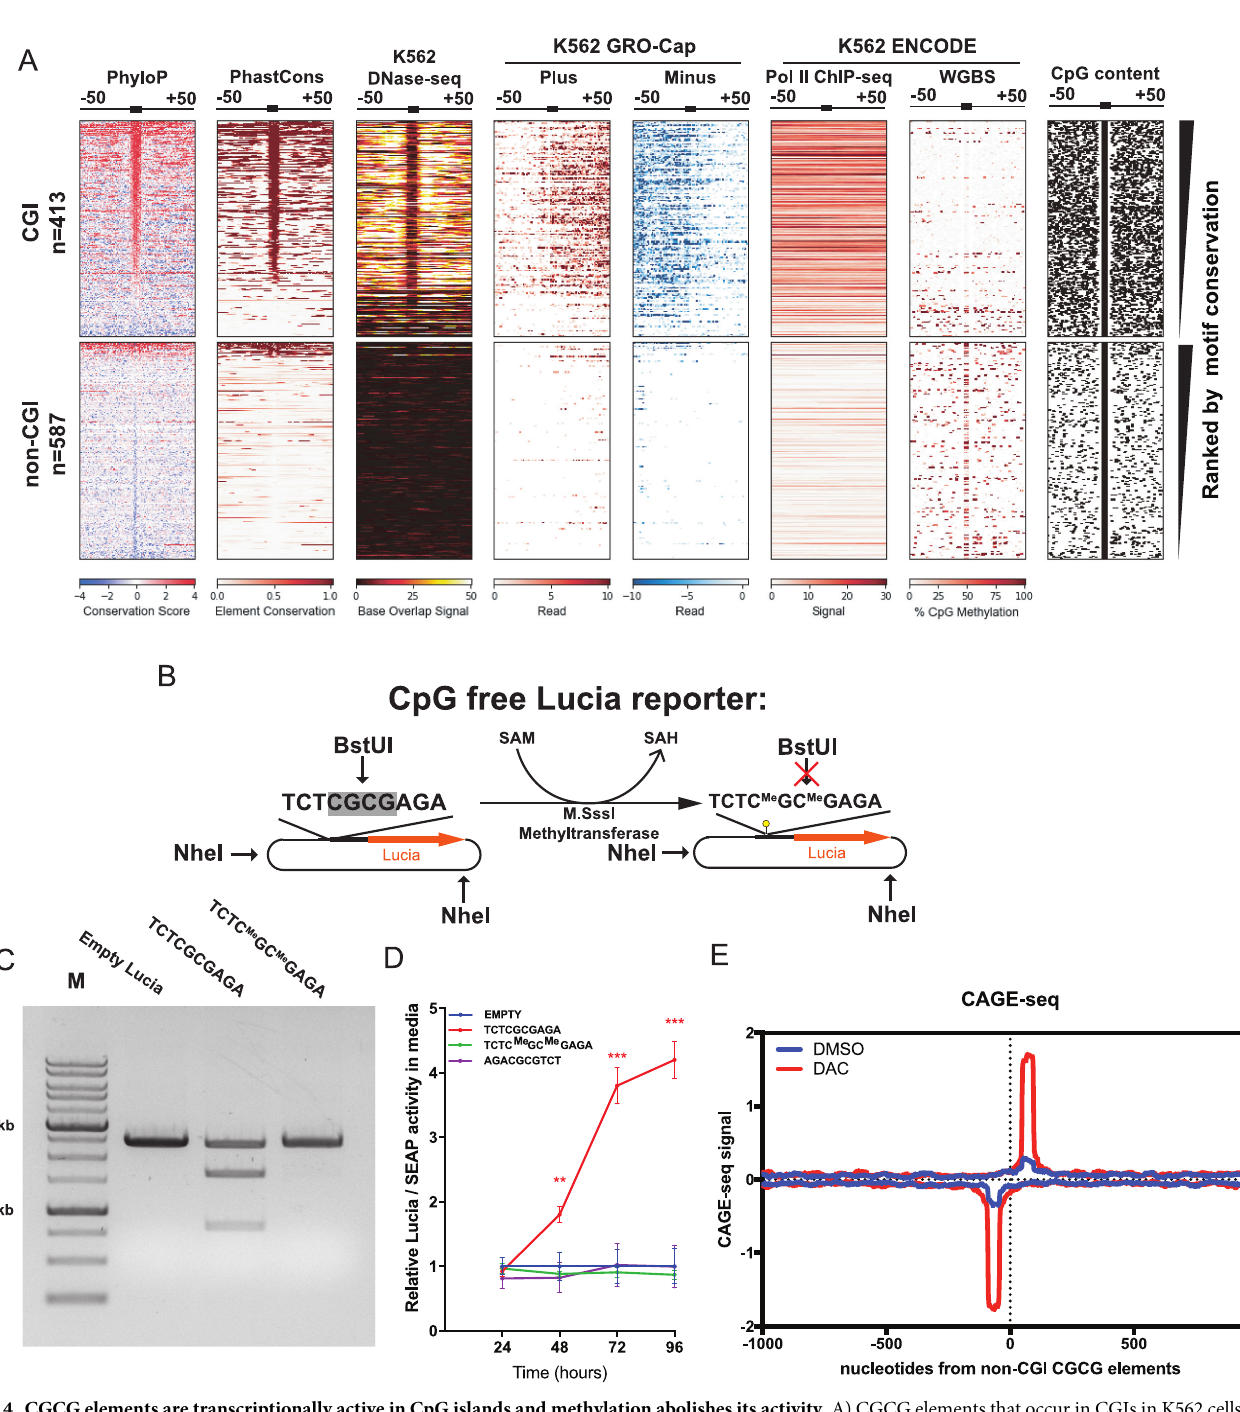
Fig 4. CGCG elements are transcriptionally active in CpG islands and methylation abolishes its activity. A) CGCG elements that occur in CGIs in K562 cells coincide with DNase-seq footprints and associate with divergent plus and minus GRO-Cap transcripts and RNA Pol II occupancy. ENCODE WGBS methylation data show increased methylation of CGCG elements in non-CGIs compared to those in CGIs. B) Methylation of CGCG elements suppresses their promoter activity. Methylation of a TCTCGCGAGA insert in a CpG-free Lucia reporter using M.SssI CpG methyltransferase and SAM. C) Methylation of TCTCGCGAGA in the construct assessed by agarose gel analyses after digestion with NheI plus BstUI (only cuts non-methyl CGCG), which produces a doublet band of 2.3Kb. D) Lucia vs SEAP (transfection control) activity driven by WT, mutant or methylated CGCG inserts in transfected HEK293T cells. Data represent the mean of three replicates +/- SD. E) Strand-specific CAGE-seq signals generated from raw CAGE-seq sequence reads described by Brocks et al. [32] from NCI-H1299 cells treated with either the DNMT inhibitor, DAC, or DMSO control.